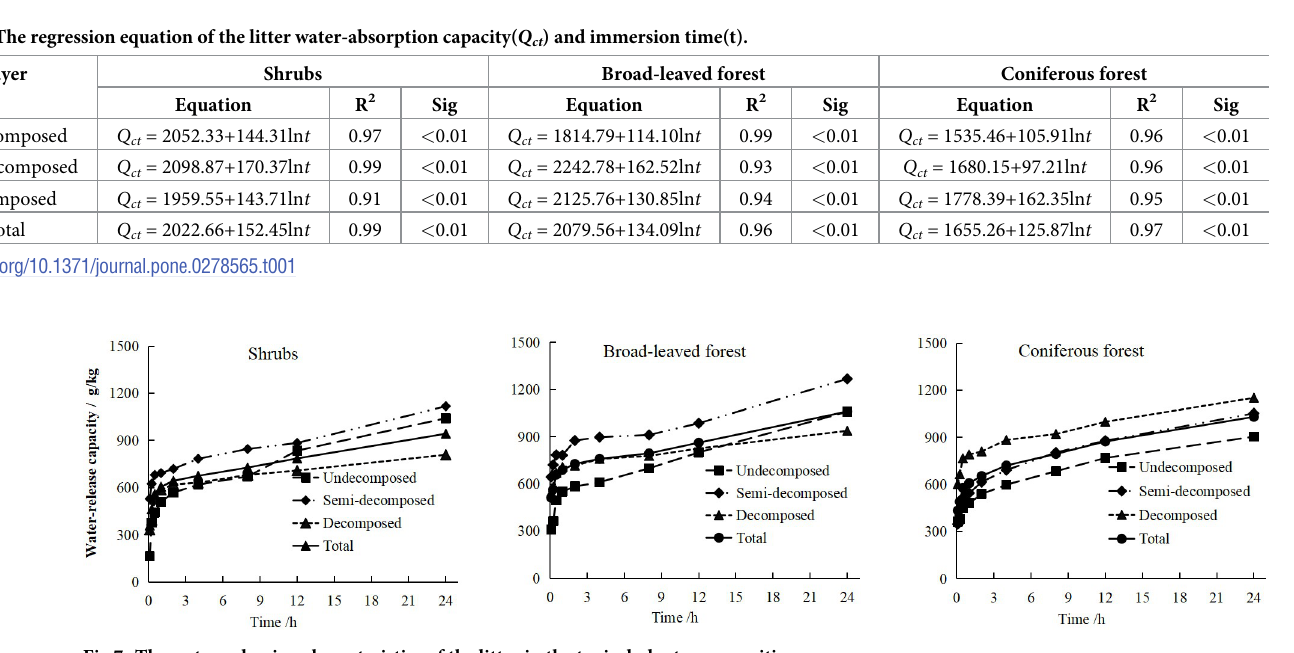
Fig 7. The water-releasing characteristics of the litter in the typical plant communities.